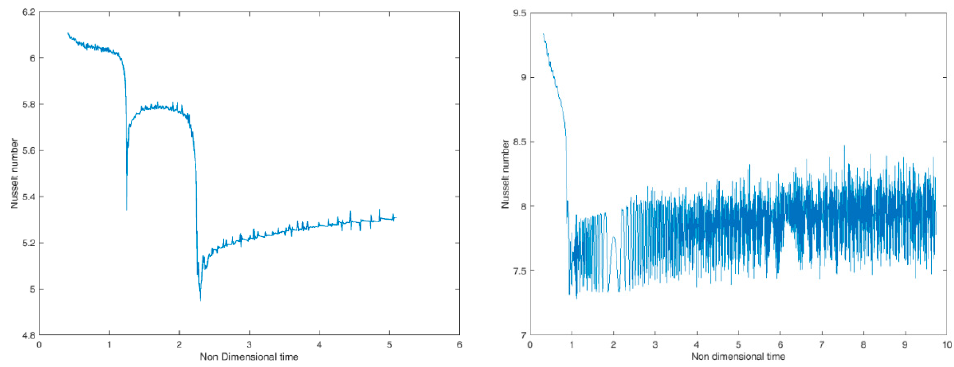
Figure 9. Nu variation with non-dimensional time for Ra = 10 5 ( left ) and Ra = 10 6 ( right ).